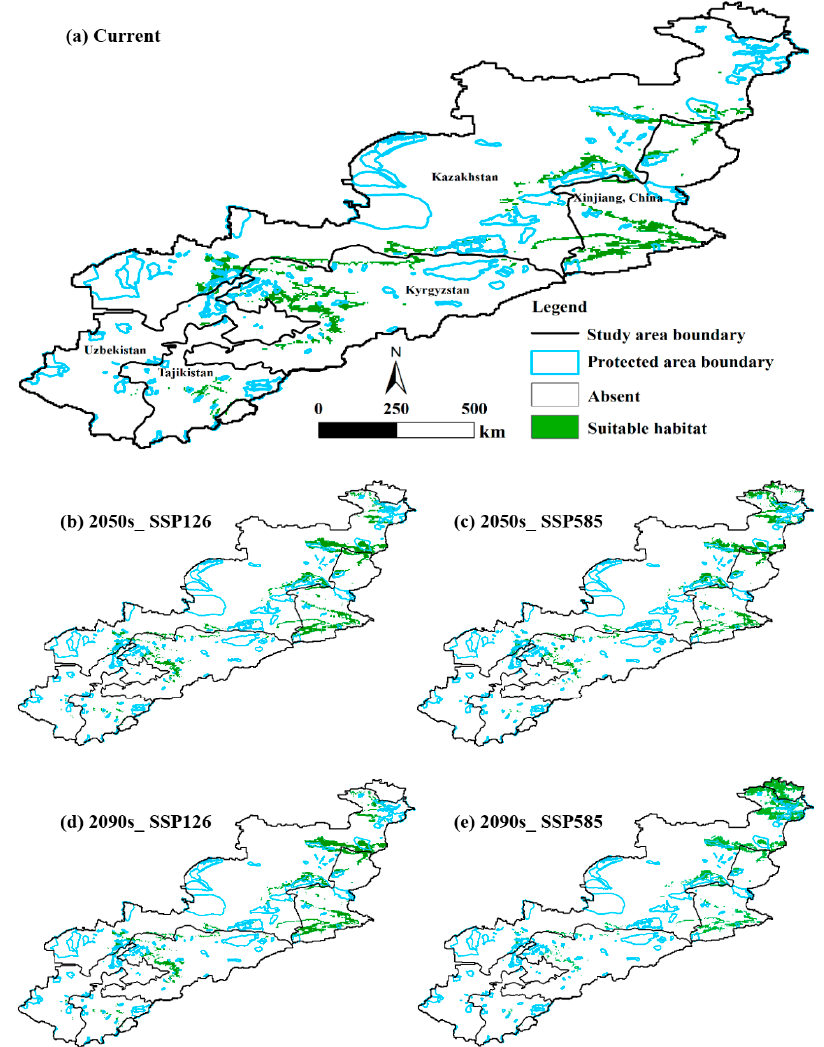
Figure 7. The wild apple suitable habitats within current protected areas under the current and future scenarios. Green areas indicate suitable habitats, while white regions indicate unsuitability. Table 1. The range size and proportion of suitable habitats for wild apple within current protected areas under the current and future scenarios.